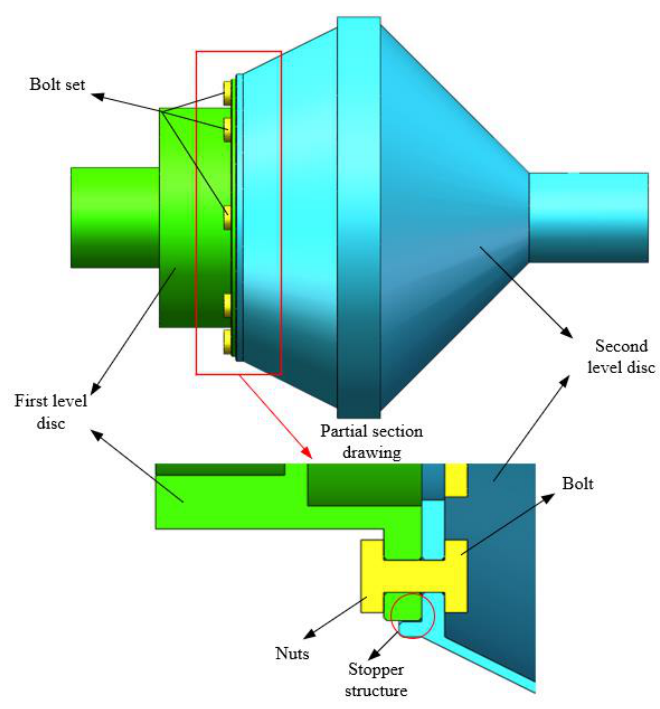
Figure 1. Simplified model of low-pressure rotor.